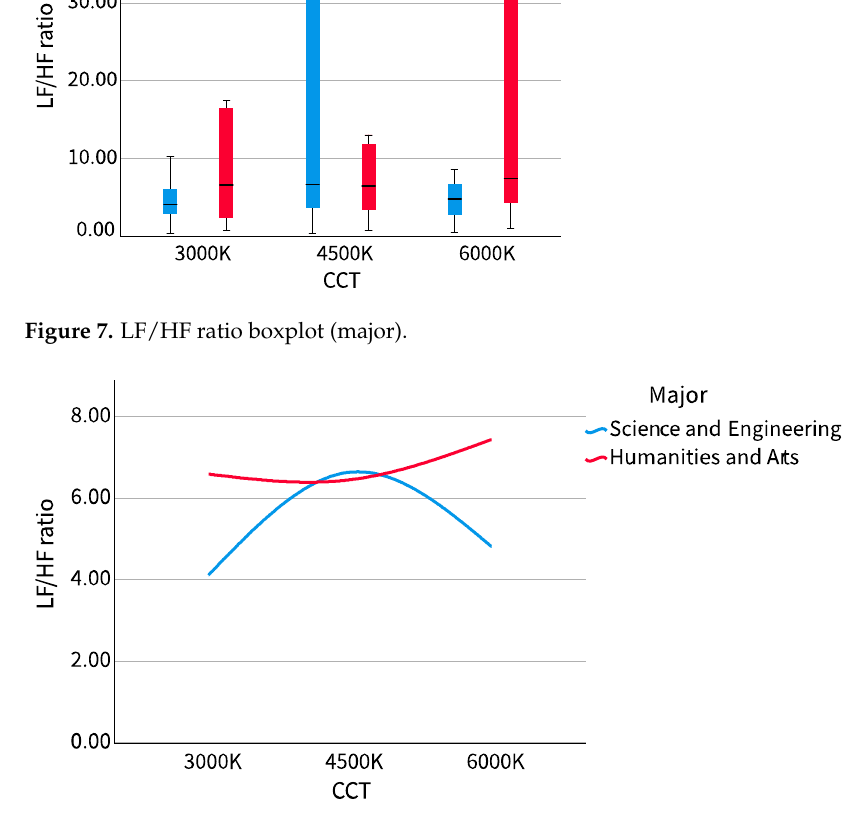
Figure 8. LF/HF ratio line chart